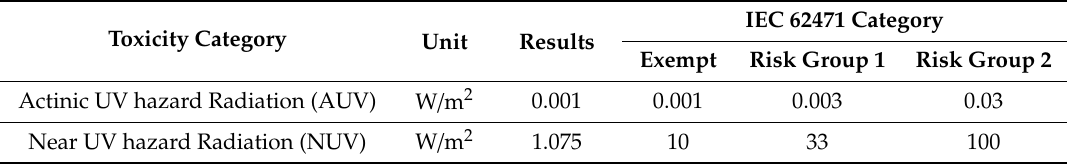
Table 2. IEC 62471, UV light spectrum toxicity category and results.